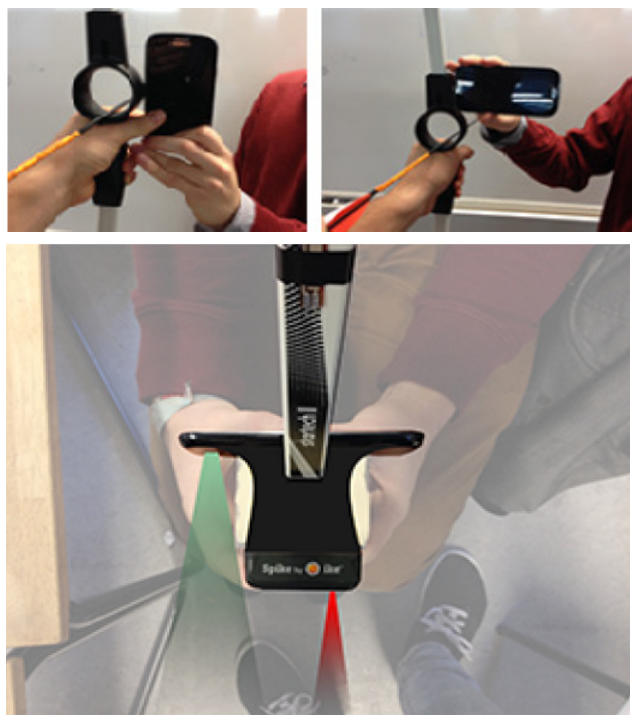
Figure 12. Optimal ArcAid hardware placement